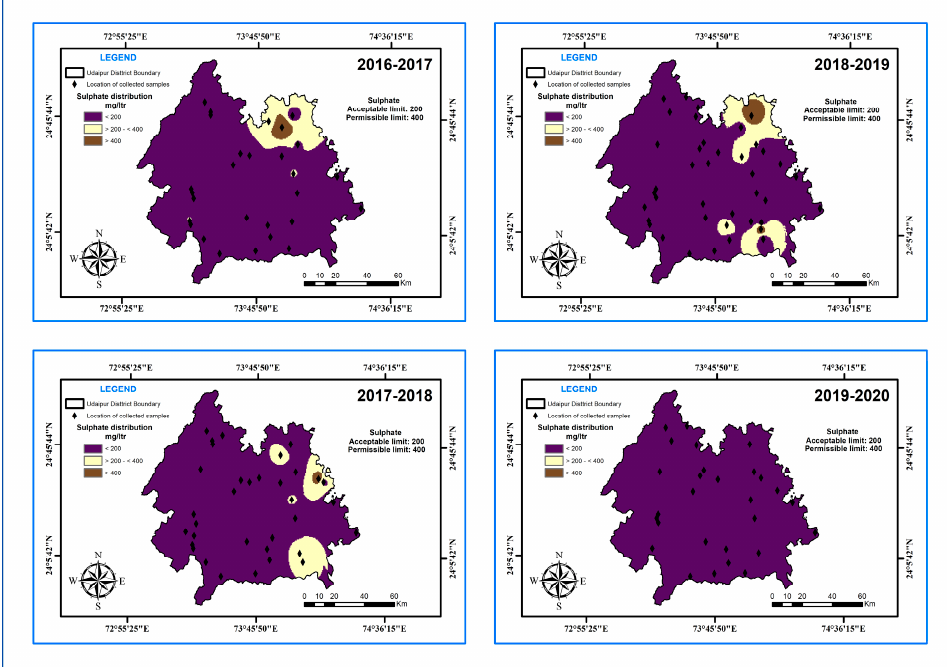
Figure 16. The changing distribution of sulfate from 2016–2018 in the study area.